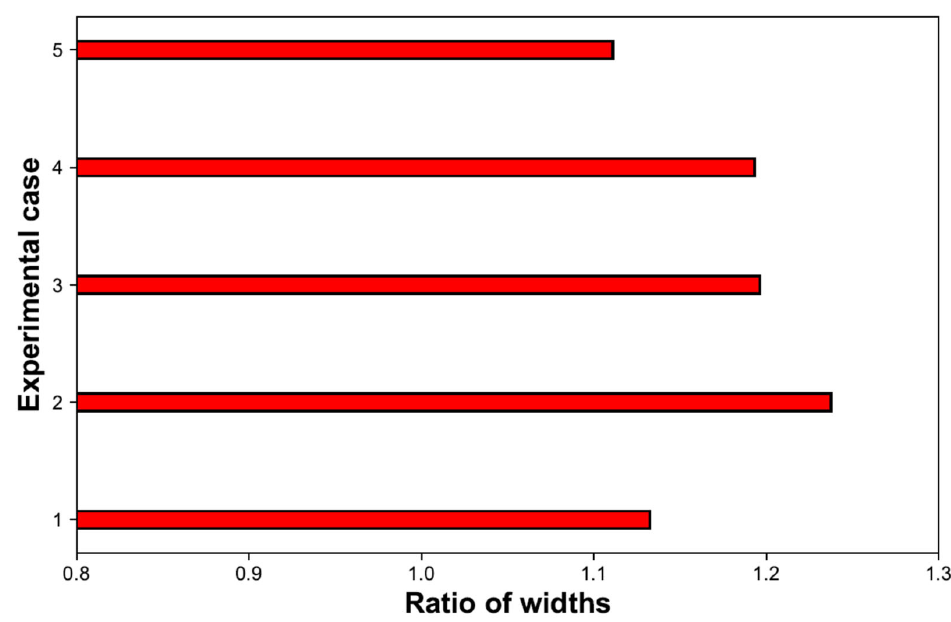
Figure 6. Ratio of top kerf width obtained with four passes, with respect to the width of the first pass under various experimental conditions.